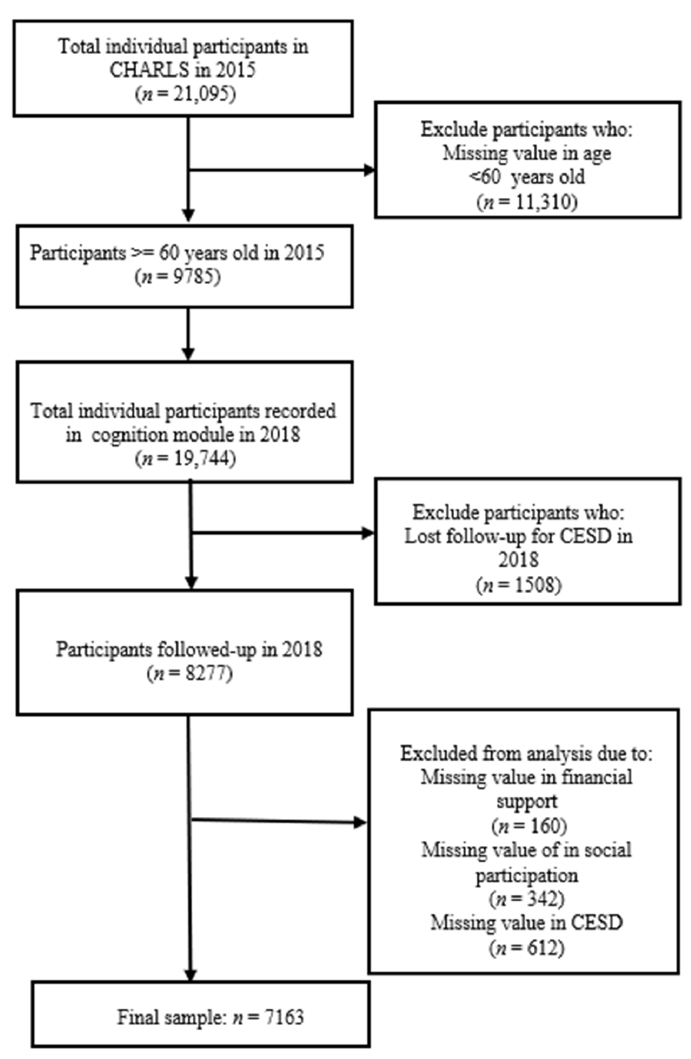
Figure 1. Flow chart of sample selection.